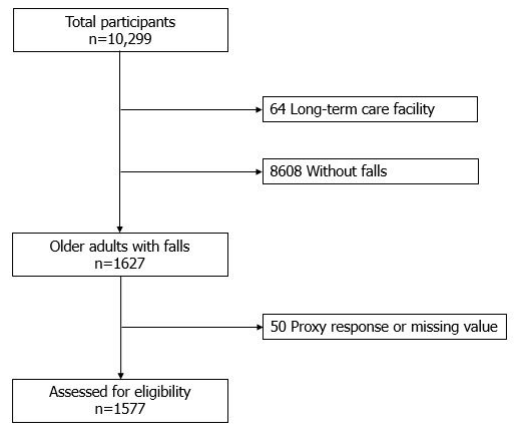
Figure 1. Consort diagram of study population inclusion.